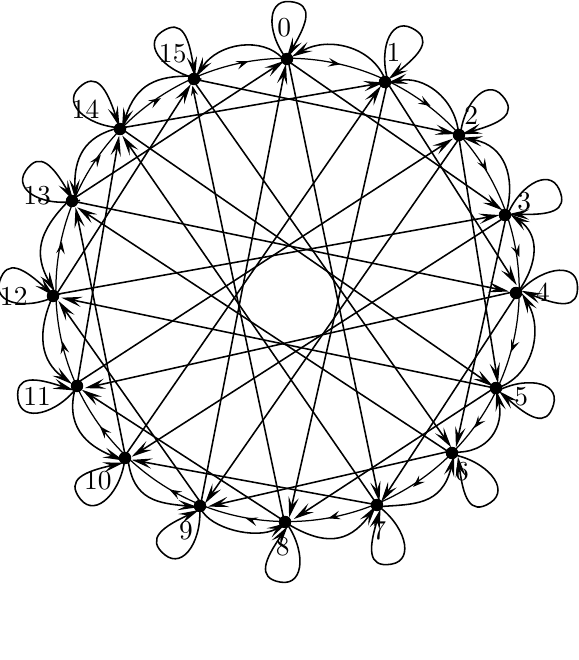
−−→ Circ (16 , { 0 , 1 , 3 , 7 , 15 } )